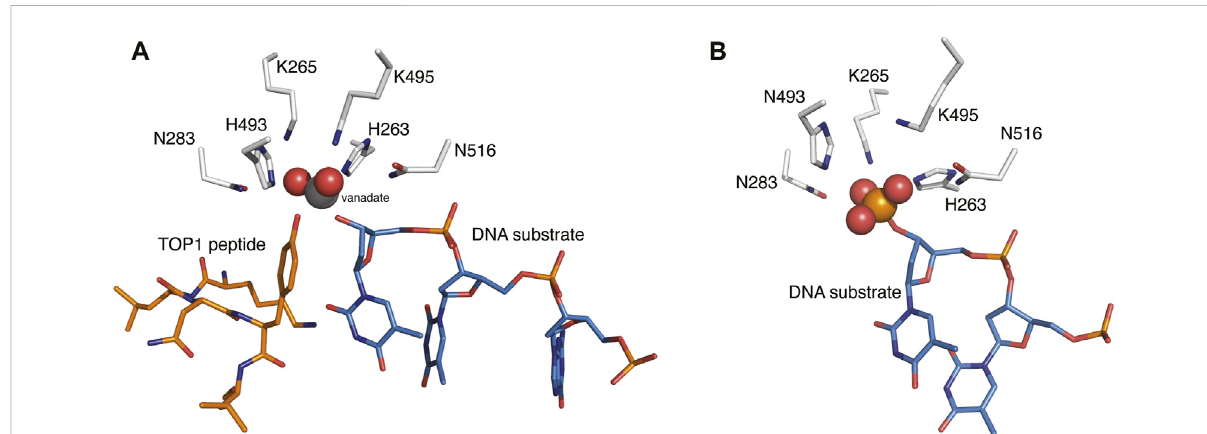
FIGURE 1 The binding modes of TDP1 substrates. (A) Structure of TDP1 (148 – 608) (carbon atoms in gray, nitrogen atoms in blue, oxygen atoms in red) complexed to single DNA strand (carbon atoms in light blue) and TOP1 peptide (carbon atoms in orange) with the phosphate mimetic vanadate highlightedinasphererepresentation(PDBcode:1NOP(Daviesetal.,2003)). (B) StructureofTDP1complexedtoaDNAstrand(carbonatomsinlight blue) with the phosphonic acid highlighted in a sphere representation (PDB code: 5NWA (Flett et al.,